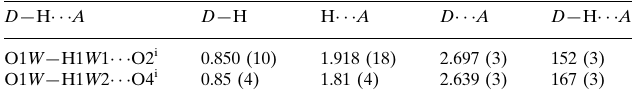
Hydrogen-bond geometry (A˚ , (cid:2)